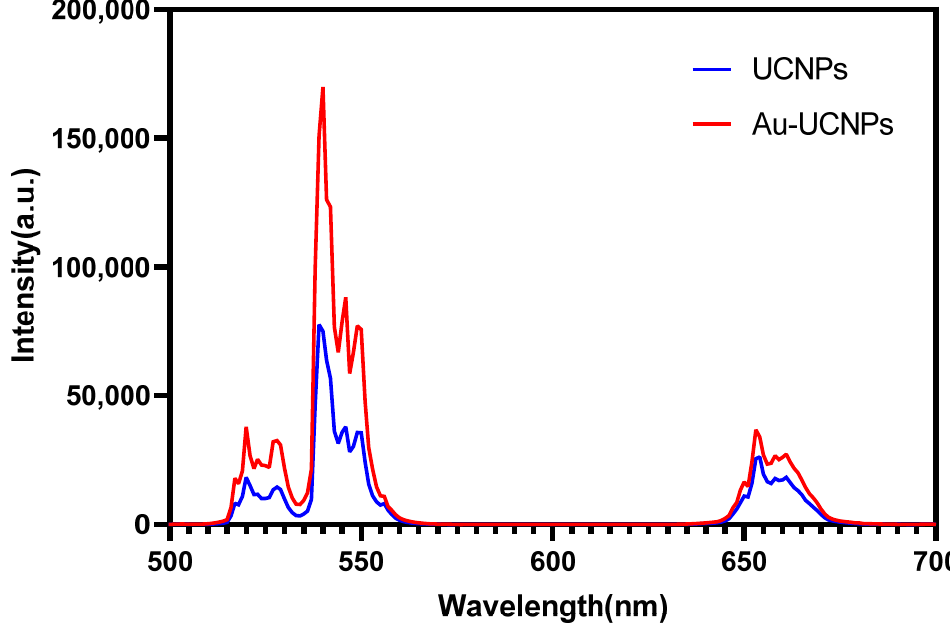
Figure 2. Luminescent intensity of UCNPs (blue) and Au ‐ UCNPs (red). The emission bands are observed at 409 nm (purple), 524 nm, 543 nm (green), and 655 nm (red) are due to the transitions of Er 3+ ions such as 2 H 9/2 → 4 I1 5/2 , 2 H 11/2 → 4 I 15/2 , 4 S 3/2 → 4 I 15/2 and 4 F 9/2 → 4 I 15/2 , respectively (Figure 3). However, it is observed that the red and green emissions become more prominent than the purple emission, which might be